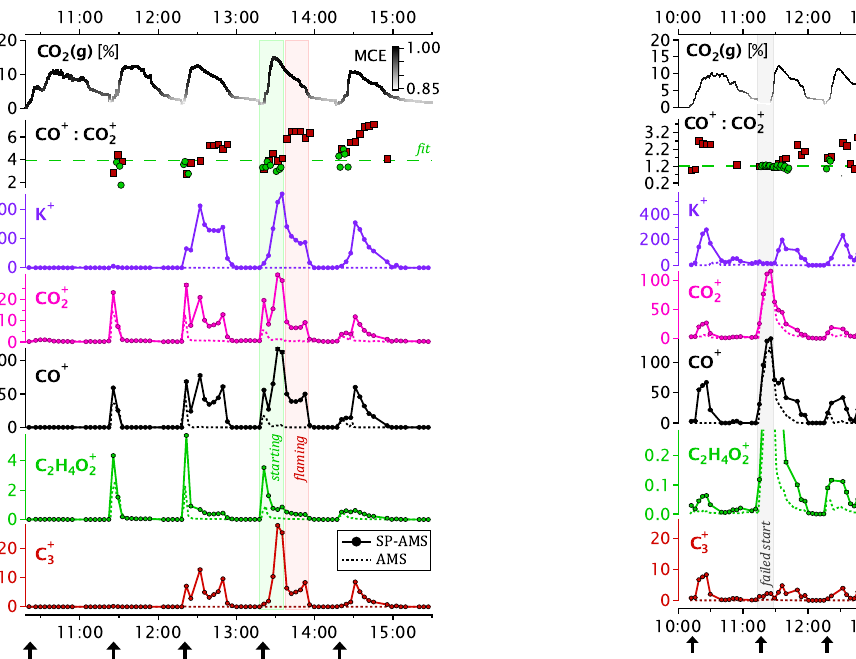
Figure 1. Time series for the fresh beech-wood-combustion experi- ment. Selected SP-AMS (solid lines with circles) and AMS (dashed lines) data are shown in nitrate-equivalent mass (proportional to ion counts). Error bars are smaller than the data symbols. The upper- most panel shows gas-phase CO 2 ( g ) concentrations in the chim- ney (proportional to combustion rate), shaded by the modified com- bustion efficiency (MCE). The second-from-top panel shows the CO + : CO + ratio (green: AMS; red: SP-AMS), which was con- 2 stant for the AMS (dashed line shows the result of a linear regres- sion of CO + against CO + ). Shaded regions exemplify “starting” 2 (green shading) and “flaming” (red shading) phases, defined using the CO + : CO + ratio. 2